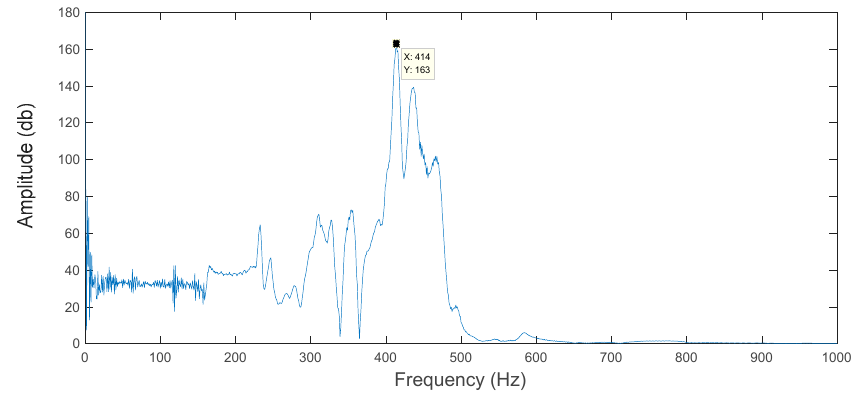
Figure 24. Amplitude-frequency curve of a 3-DOF motion device.